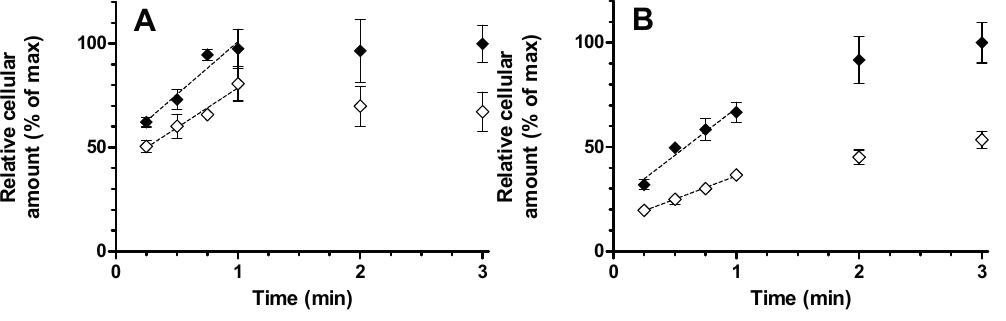
Figure 4. Time-dependent uptake of ( A ) montelukast and ( B ) E 1 3S into human hepatocytes. Incubations were performed with substrate alone ( ♦ ) and in the presence of 10 µM rifampicin ( ◊ ). Relative initial uptake rates were assessed from linear fit to data obtained from 15 to 60 s (dashed). Results are given as mean ± S.D., n =